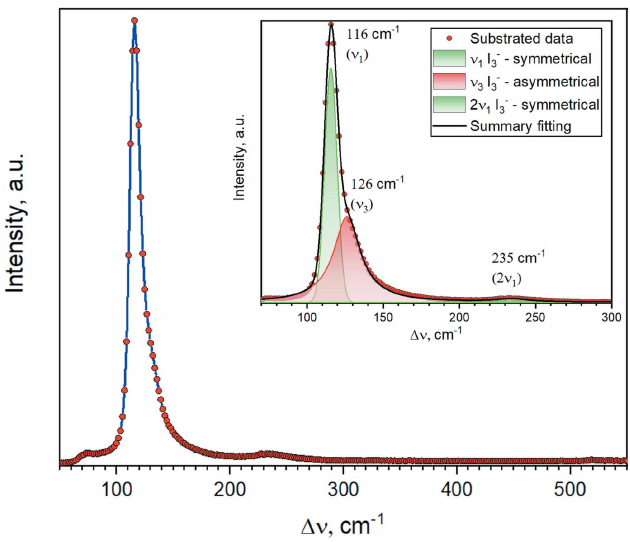
Figure 1 ( a ) FAI 3 single crystals used for the determination of the crystal structure. ( b ) FAI 3 crystal structure with solid lines indicating covalent bonding and dashed lines indicating the intermolecular hydrogen